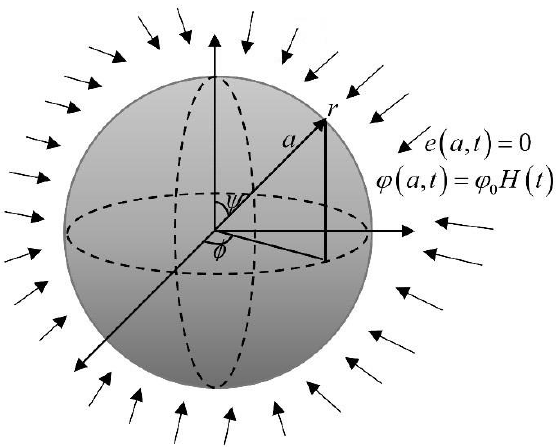
Figure 1. The isotropic homogeneous thermoelastic solid sphere.